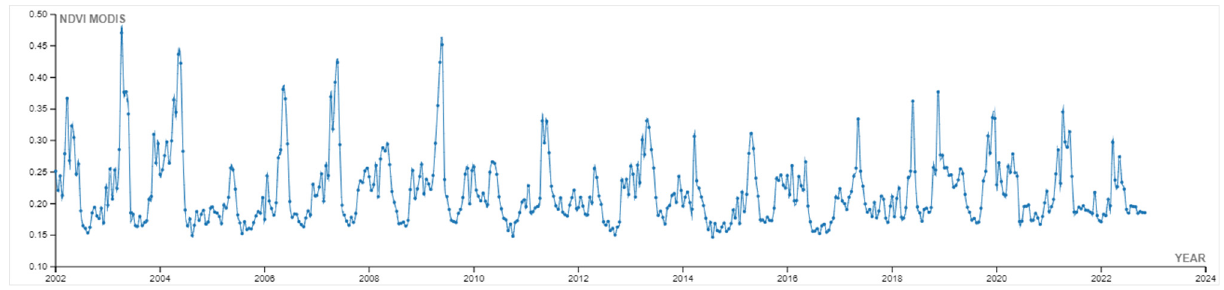
Figure 7. Spatiotemporal phenological profiles of plotted NDVI values from the MODIS/006/MOD13Q1 ‘NDVI’ Collection, clipped on the AOI.shp, time interval: 20 years (2002–2022).